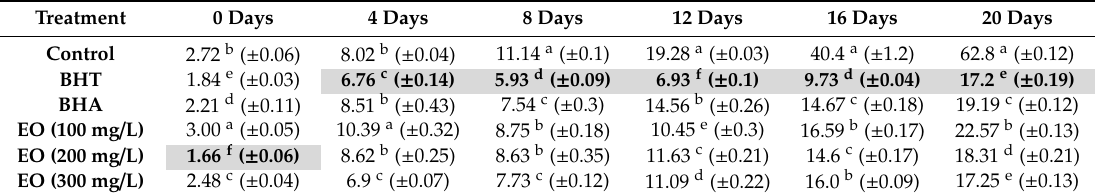
Table 4. Inhibitory e ff ect of the P. sylvestris seed essential oil on the secondary oxidation of